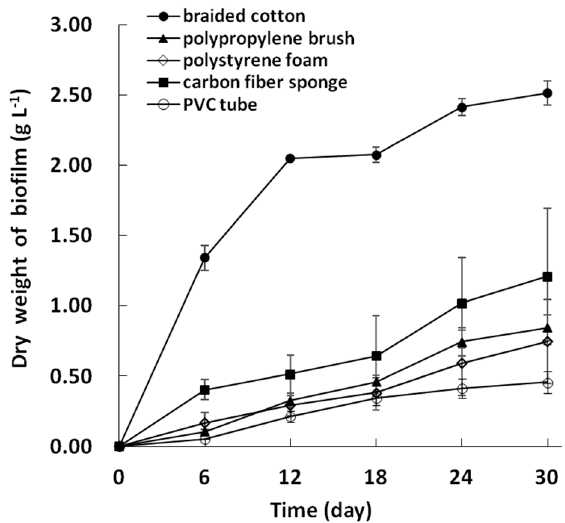
Figure 2. The biomass density of algal–bacterial biofilm in the algal–bacterial biofilm batch reactor (ABBR) with different biofilm carriers. (Error bars represent the standard deviation, N = 2).